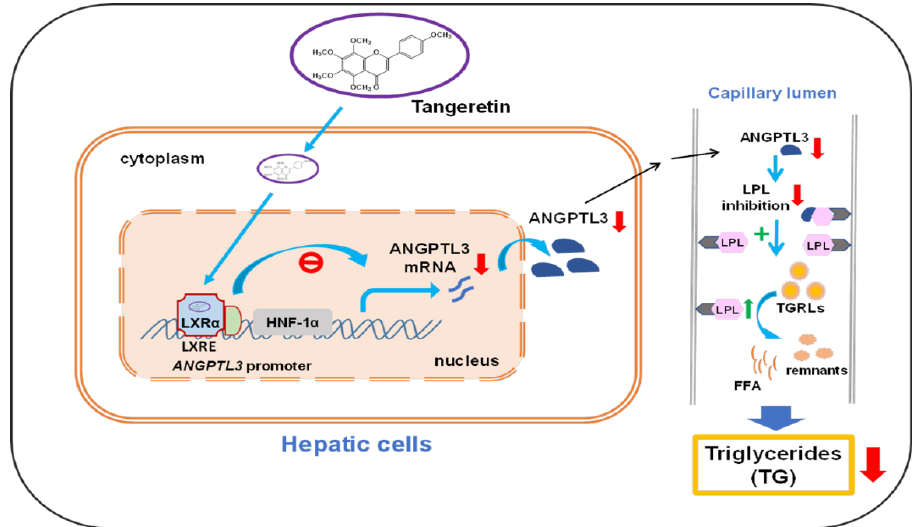
Figure 10. A hypothetical model for the regulation of the LXRα-ANGPTL3-LPL pathway by tangeretin. Tangeretin inhibits the mRNA and protein expression of ANGPTL3 by counteracting LXRα-mediated transcriptional activation in hepatic cells, resulting in a restoration of LPL activity, increases in TGRL metabolism, and a reduction in TG levels in circulation.